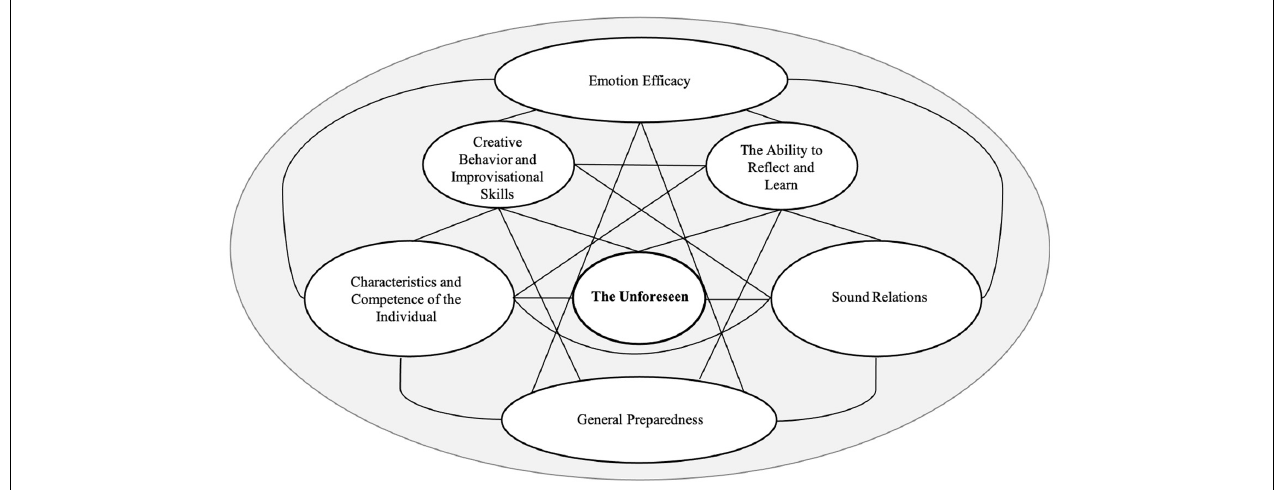
FIGURE 3 | The Resilience Competence Face Framework of the Unforeseen© showing the six main types of